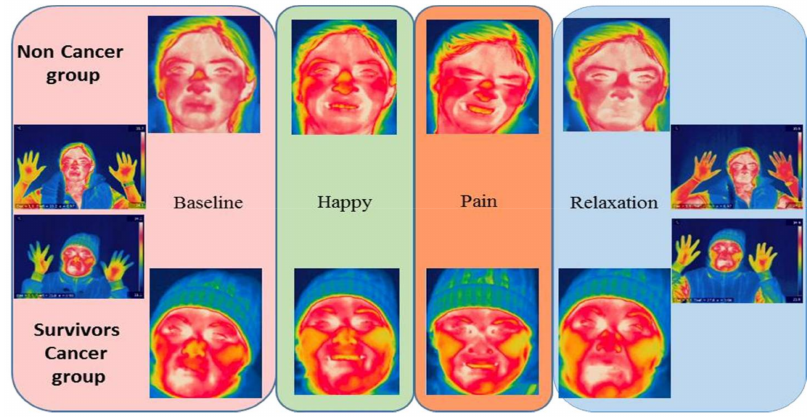
Figure 2. Psychophysiological effect of facial expression. The voluntary facial action had an effect on temperature.